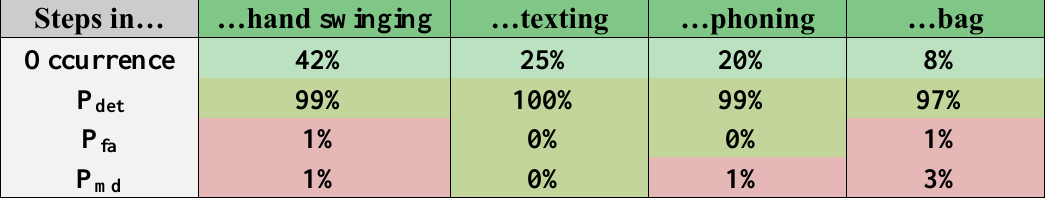
Table 2. Step detection algorithm performance for the ―free motion data